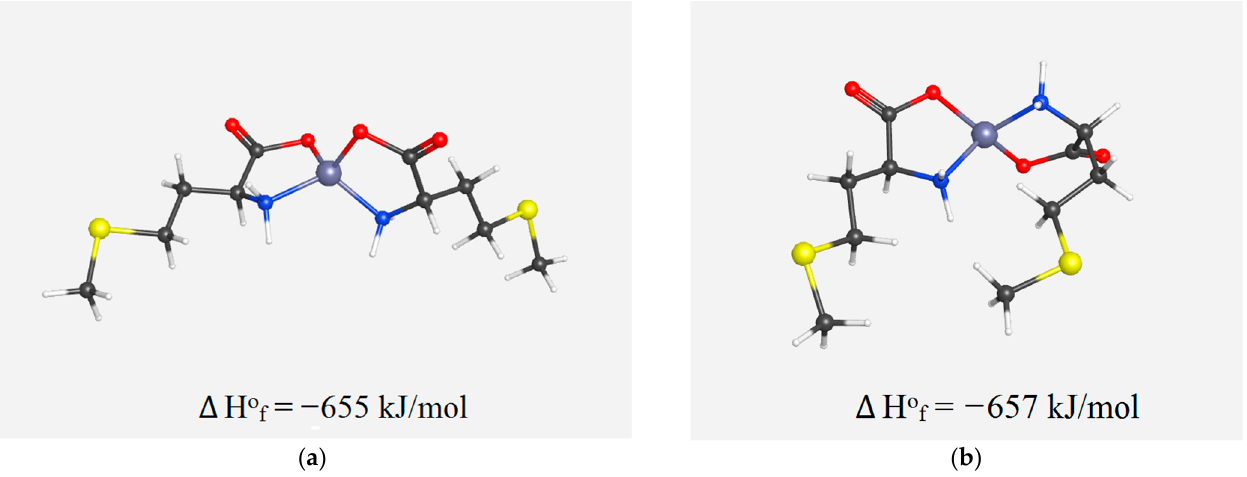
Figure 10. Spatial structure of chelate complexes cis-Zn(Met) 2 ( a ) and trans-Zn(Met) 2 ( b ) with calculated values of heat of formation ∆ H° f .